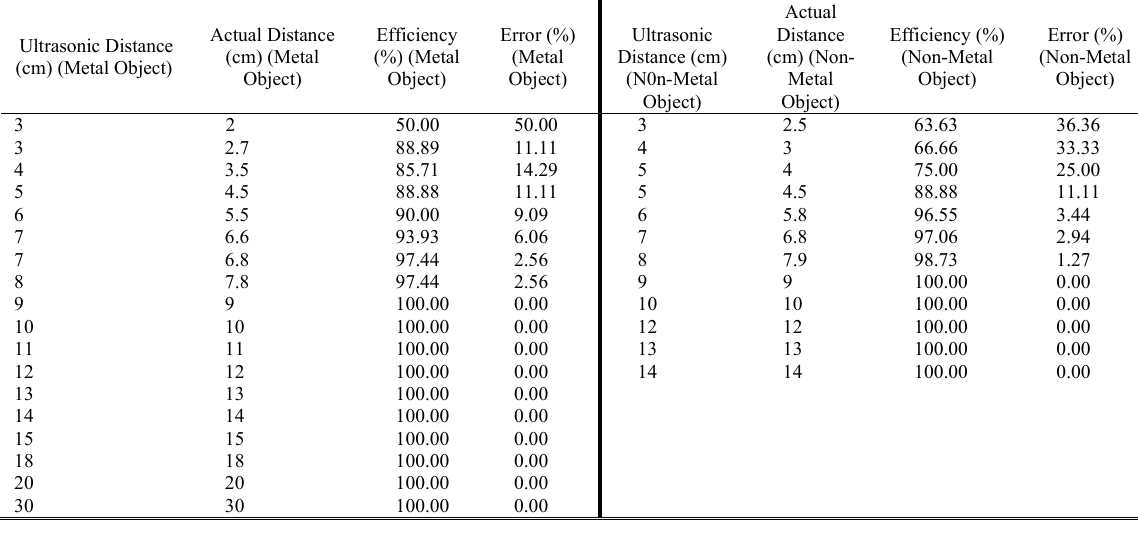
TABLE 3 D ISTANCE M EASUREMENT OF U LTRASONIC AND A CTUAL V ALUE F OR B OTH M ETAL AND N ON -M ETAL O BJECT